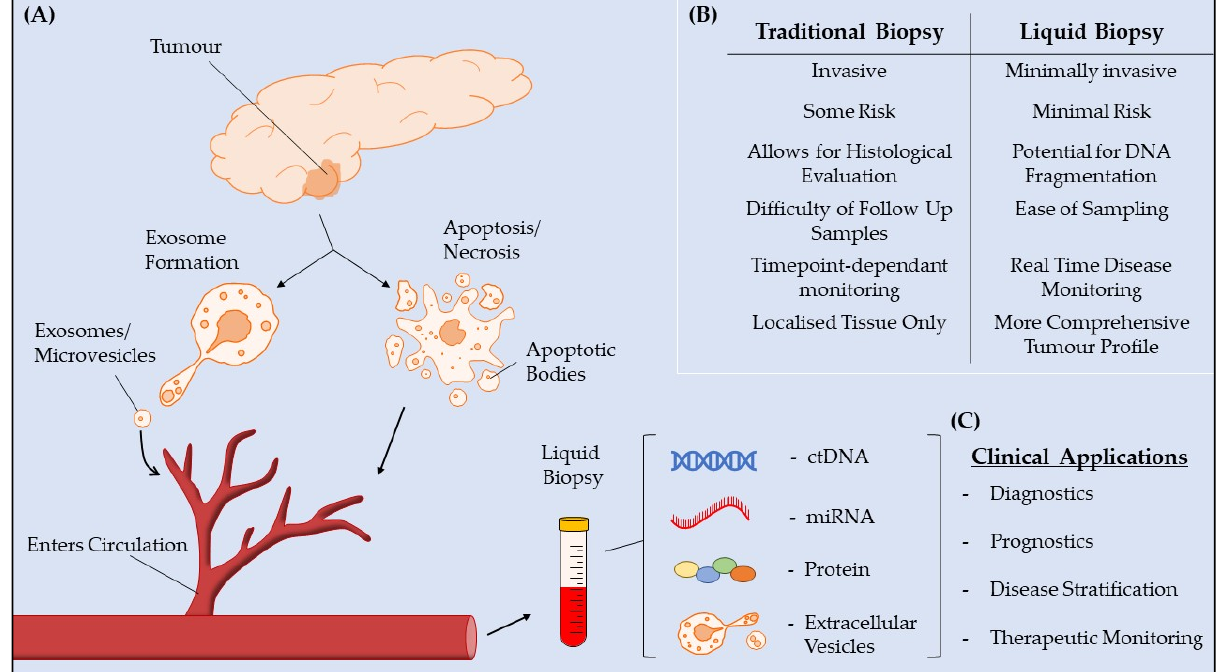
Figure 1. Liquid biopsies for PDAC. ( A ) Mechanisms through which various tumor biomarkers enter circulation. Extracellular vesicles, such as exosomes, microvesicles, and apoptotic bodies bud off from tumor cells and enter circulation. Circulating tumor (ct) DNA, miRNA and proteins are secreted from tumor cells or released through cellular apoptosis and necrosis. ( B ) Comparison between liquid and traditional biopsies. ( C ) Potential clinical applications of liquid biopsy-based bi- omarkers in PDAC.